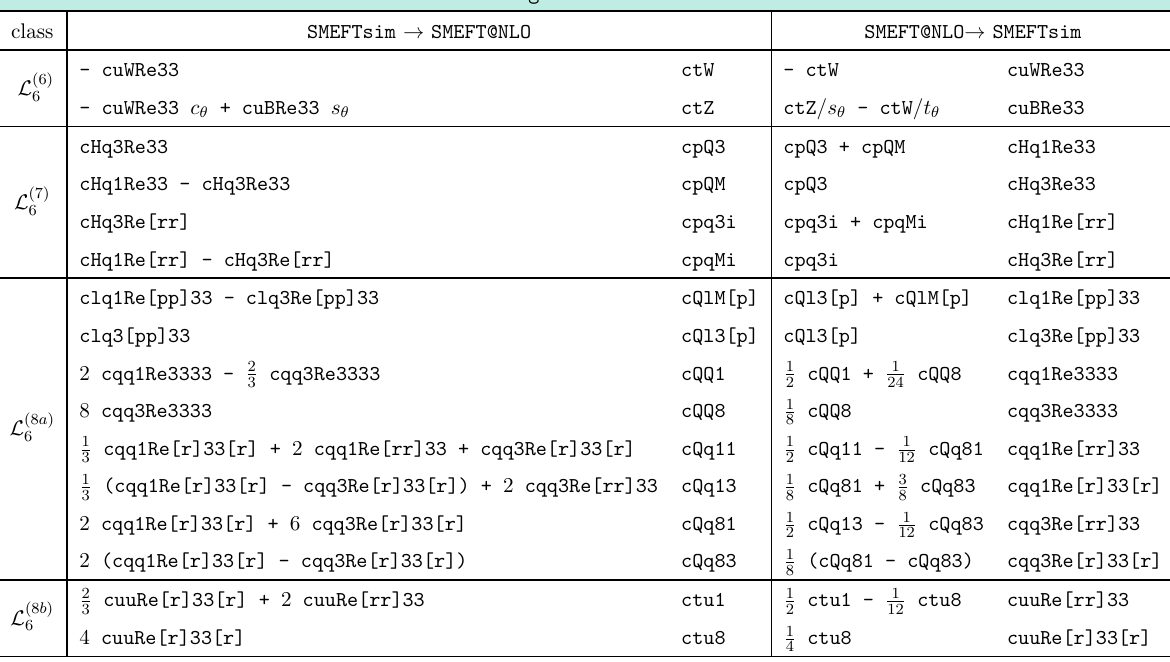
Table 31 . Conversion table between the SMEFT parameters defined in the general version of SMEFTsim and in SMEFT@NLO v1.0 : parameters that require a basis rotation. Lepton flavor